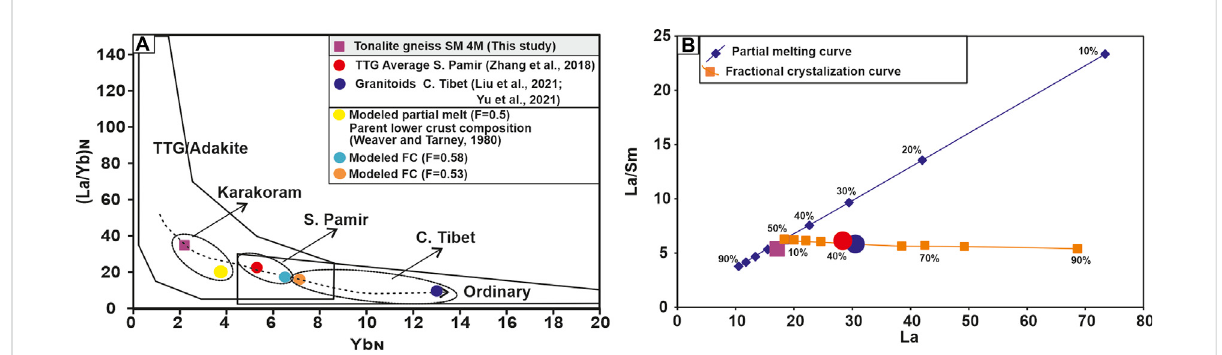
FIGURE 7 Calculated trendsobtained fromgeochemical modeling ofpartial melting(PM)ofama fi clowercrust(Weaverand Tarney,1980),andfractional crystallization (FC) of the melt produced (50%) shown in terms of: (A) (La/Yb) N versus Yb N (B) La/Sm versus